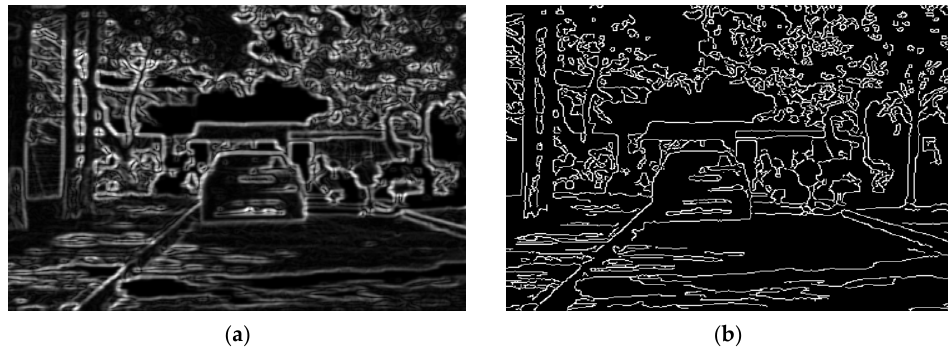
Figure 10. Operator edge-detection results. ( a ) Sobel edge detection. ( b ) Canny edge detection.